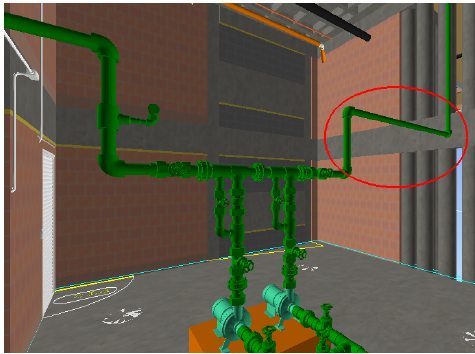
Figure 4: Insuflcient height causing necessary